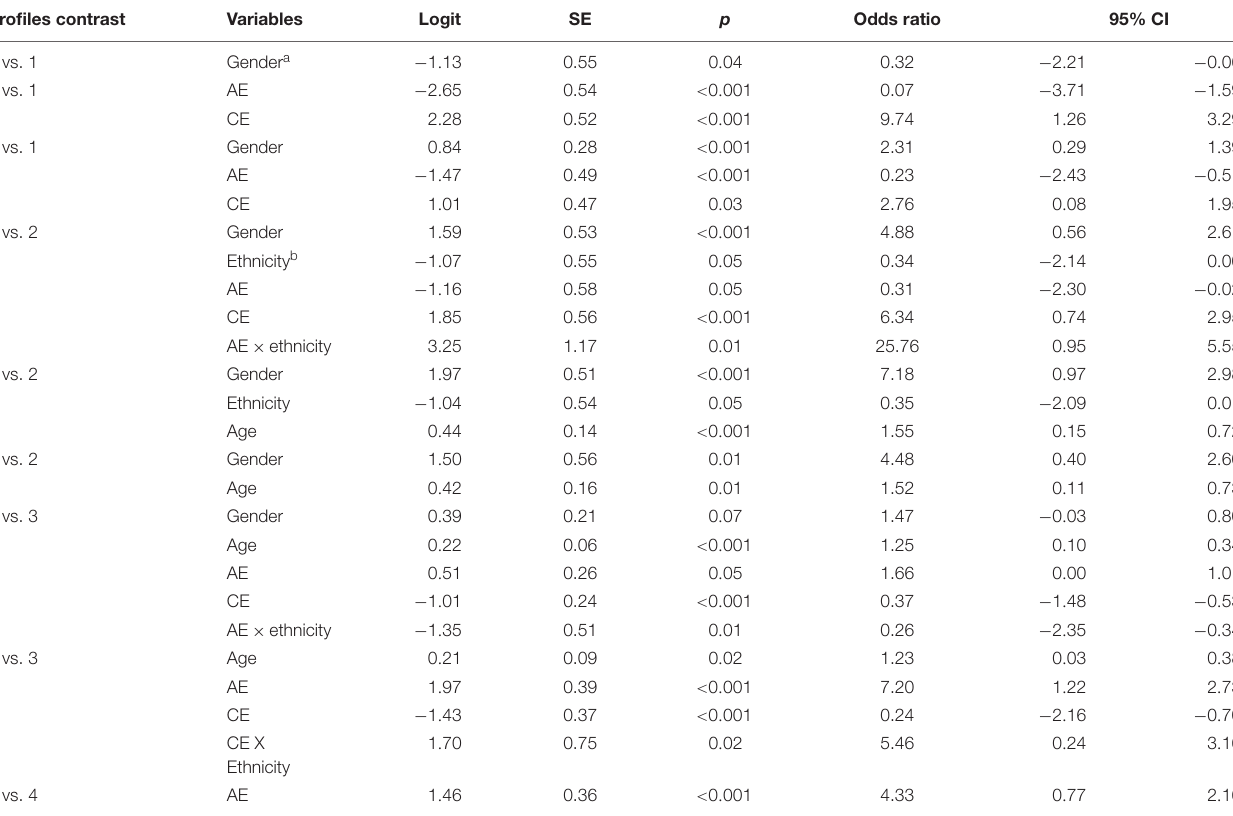
TABLE 5 | Multiple multinomial regression analysis predicting psychosocial adjustment profiles from empathy, ethnicity, sociodemographic characteristics, and interaction effects. Profiles